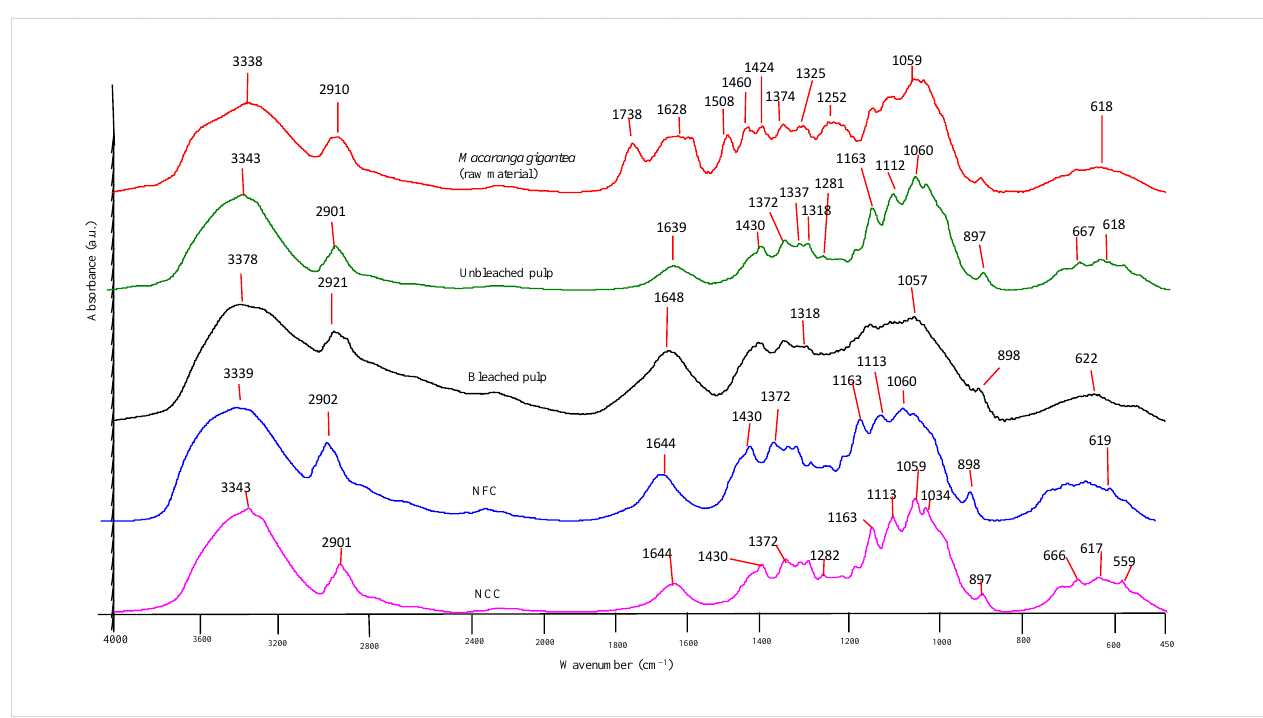
Figure 4. FTIR spectra from each processing stage, i.e., raw material Macaranga to nanocellulose. XRD is one of the essential characterization techniques for nanocrystals due to its capability to expose the crystalline order of the material. In addition, it has become one of the basic methods for crystallography studies because of the direct correlation between the diffraction pattern and crystal structure. XRD was conducted on all samples to observe their respective crystallinity changes. The XRD diffraction pattern for all samples corre- sponds to the cellulose I β polymorph, in which distinctive peaks appear at 2θ values of 15, 16, 22.5, and 34 ascribed to crystal planes 110, 110, 200, and 040, respectively (Figure 5). Cellulose I β is commonly present in the plant kingdom. The estimated crystallinity value was found to increase after the sample was subjected to each treatment. The crystallinity index values were 54%, 55%, 60%, 70%, and 69% for raw Macaranga, unbleached pulp, bleached pulp, NFC, and NCC respectively. The increased value of crystallinity index ob- served from raw material to nanocellulose can be ascribed to the removal of amorphous fractions such as lignin and hemicellulose.